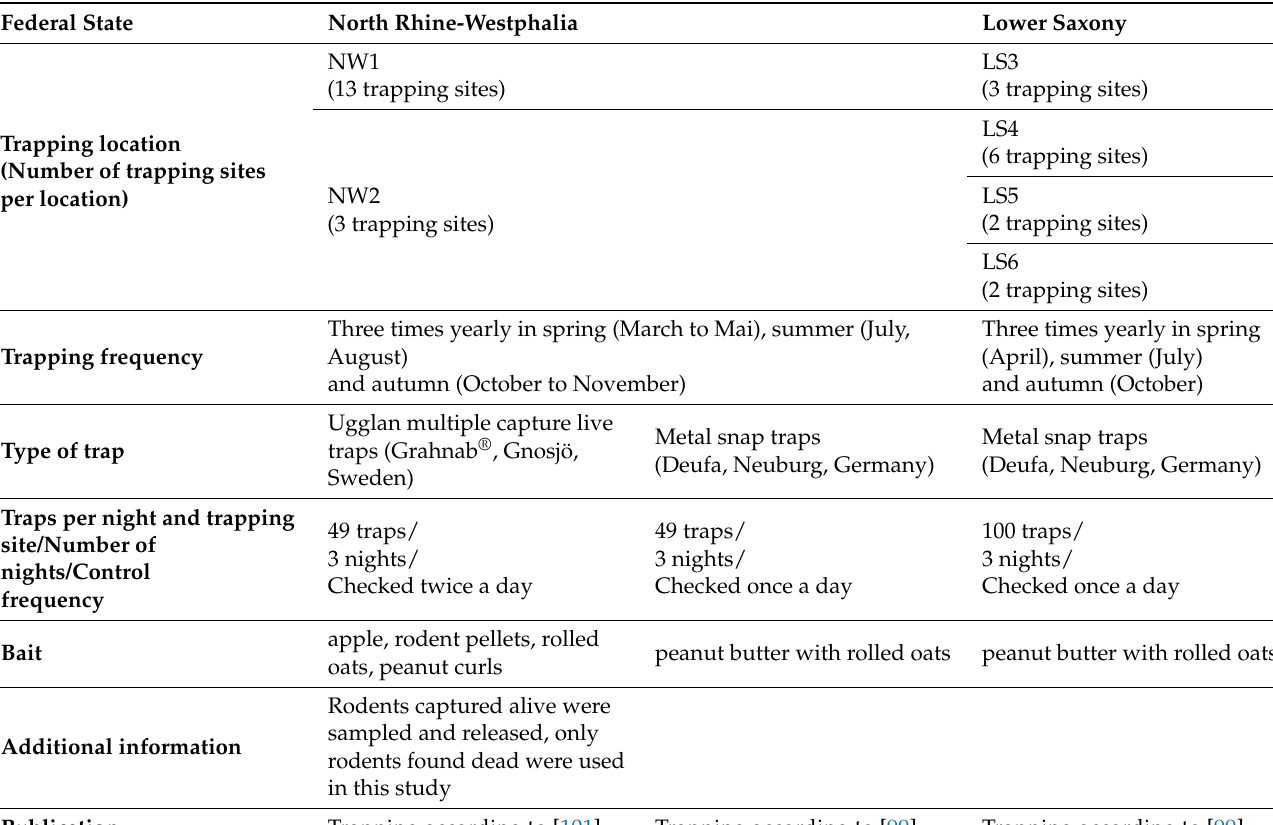
Table A1. Details of rodent trapping in transect North-Rhine Westphalia and Lower Saxony, Germany in the years 2018 to 2020.